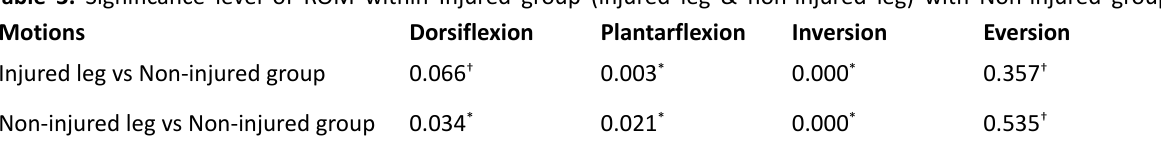
Table 3. Significance level of ROM within Injured group (injured leg & non-injured leg) with Non-injured group Motions